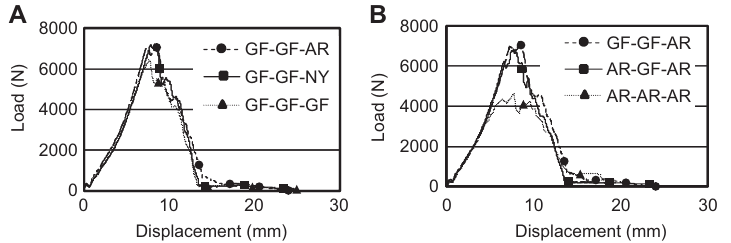
Figure 6 Load-displacement curves of the BWK composites during the plate bending impact test: (A) effect of stitch yarn and (B) effect of biaxial yarn.